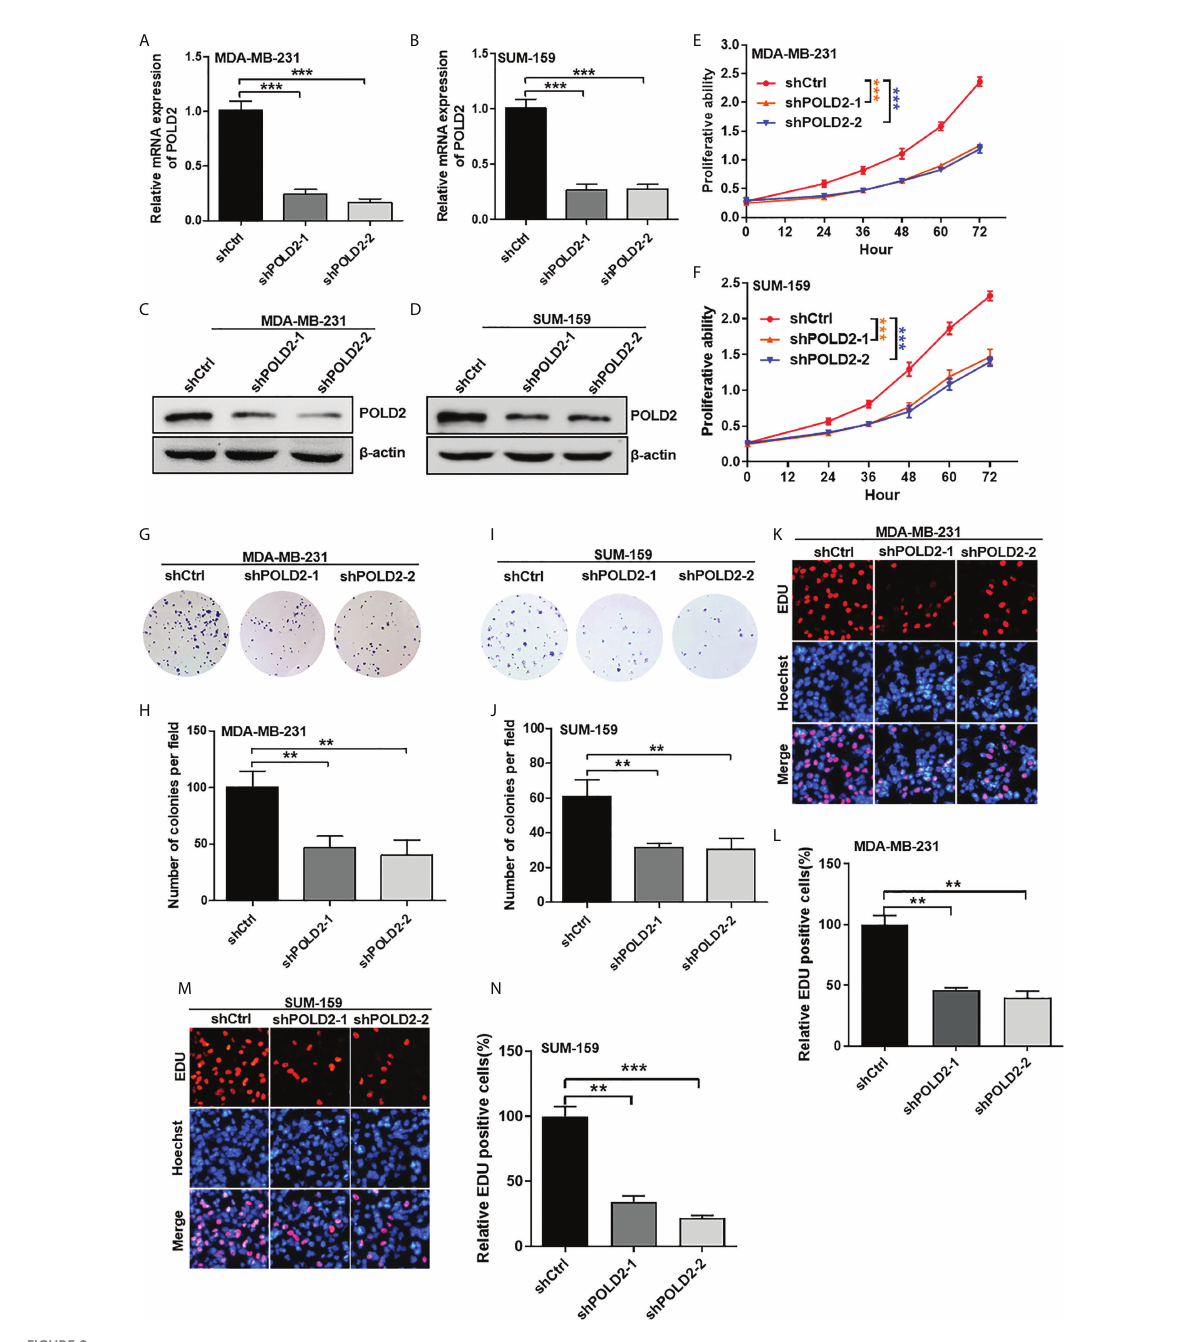
FIGURE 2 Inhibition of POLD2 reduces TNBC proliferation. (A – D) qRT-PCR (A, B) and Western blot (C, D) analysis of POLD2 knockdown in MDA-MB-231 and SUM-159 cells. *** P < 0.001. (E, F) The effect of POLD2 on MDA-MB-231 and SUM-159 cell viability was determined by a CCK-8 assay. *** P < 0.001. (G – J) The effect of POLD2 on MDA-MB-231 and SUM-159 cell colony formation abilities was determined by colony formation assay. ** P < 0.01. (K –